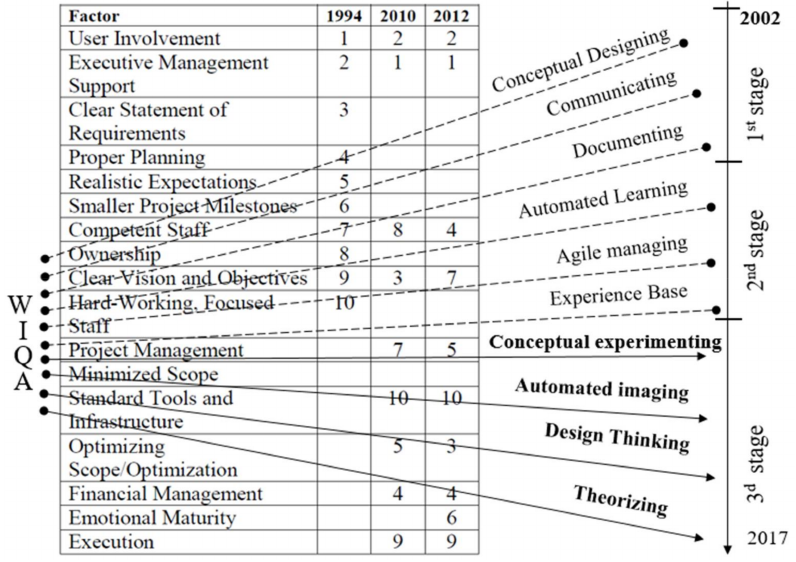
Figure 1. Retrospection of mastering the question-answer (QA)-nets.